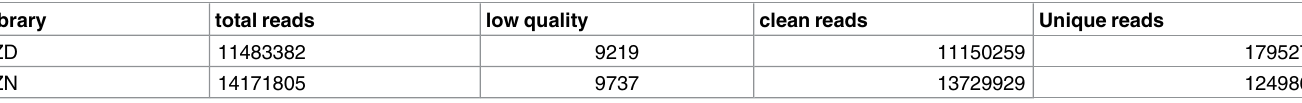
Table 1. Statistics of small RNA sequences from ZZN and ZZD libraries.